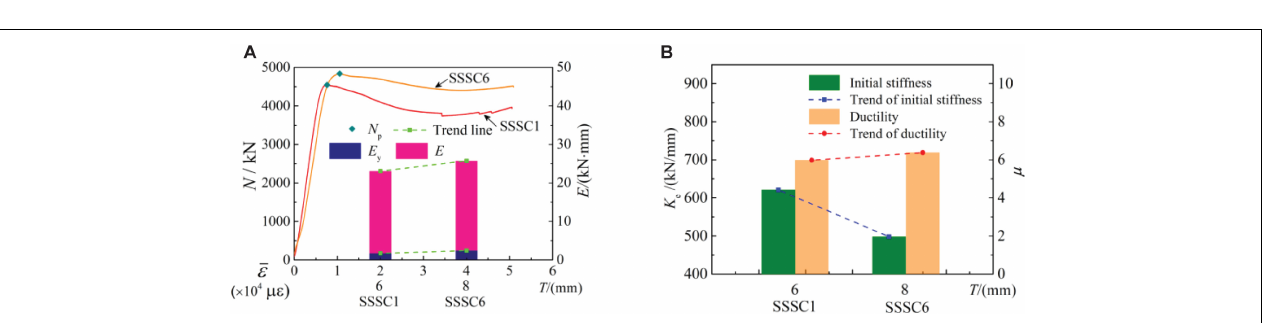
FIGURE 9 | Effect of stirrup spacing. (A) Variation of peak load, strain, and energy dissipation. (B) Stiffness degradation and ductility.